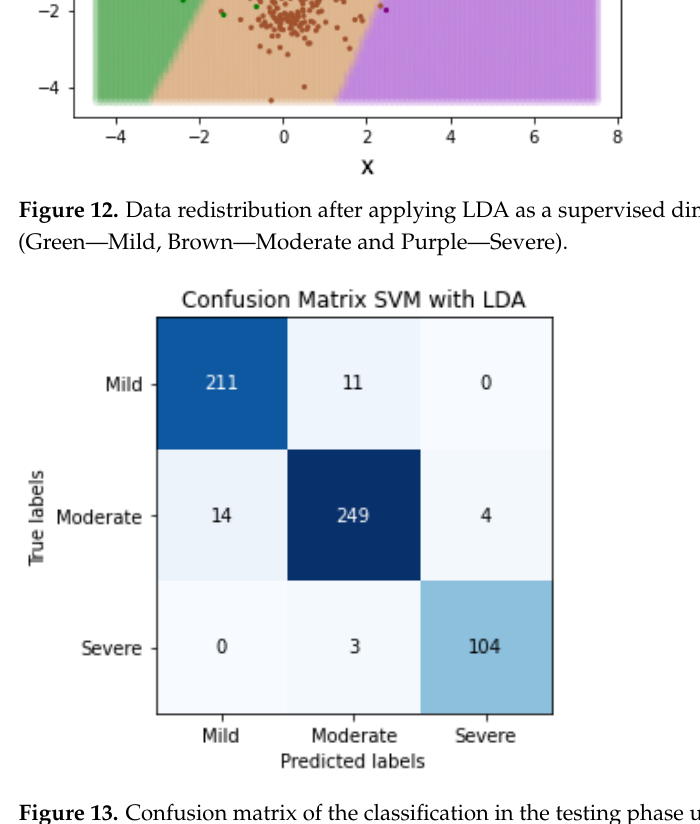
Figure 13. Confusion matrix of the classification in the testing phase using SVM and LDA, for detect- ing the severity degree of the lungs of a patient (summary of 5 folds evaluated in the testing